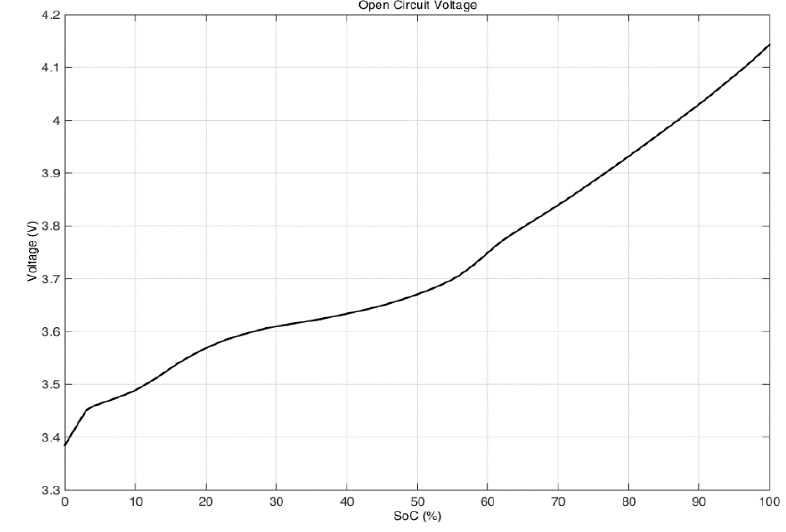
Figure 3. Average open circuit voltage-state of charge (OCV-SOC)